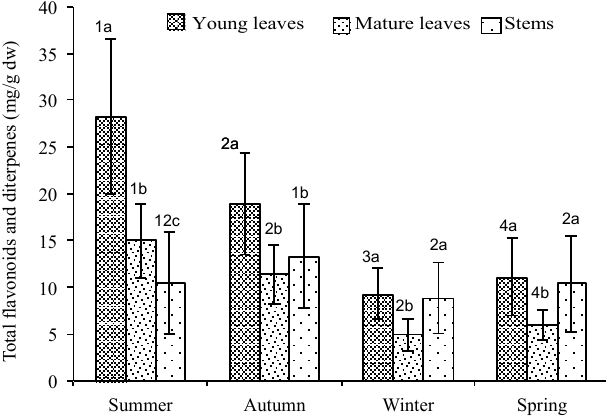
Figure 3. Total flavonoids and diterpenes of the exudate of 20 individuals of C. ladanifer in the different tissues analysed, by season and in the different season analysed, by tissues (mg/g dw). Error bars, means, standard deviation. Mean of the two years ( n = 20 individuals × 3 replicates × 2 years = 120). 1 2, 3, 4: different numbers mean significant differences between seasons p < 0.05 (Wilcoxon Test). a, b, c : different letters mean significant differences between young and mature leaves and steams p < 0.05 (Wilcoxon Test).